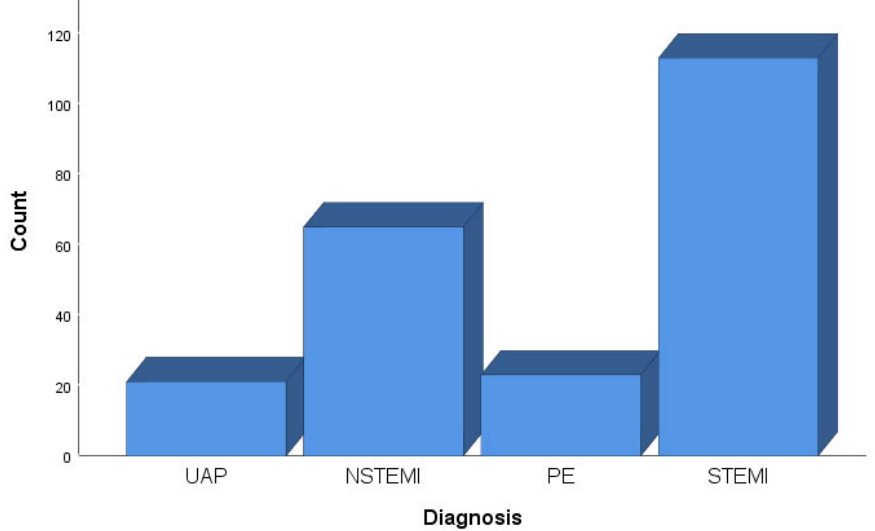
Figure 2. Distribution of diagnosis among subjects (n = 222). Legend: UAP: unstable angina pectoris, NSTEMI: non-ST-elevated myocardial infarction, PE: pulmonary embolism, STEMI: ST-elevated myocardial